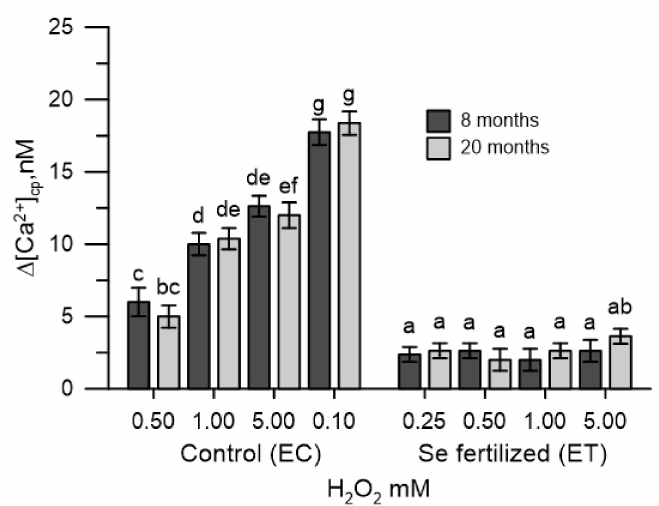
Figure 3. Effects of H 2 O 2 (0.25 to 5.0 mM) in the cytosolic Ca 2+ of olive pollen, in the presence of the extracts of the germinative apexes from untreated plants (EC 8 , EC 20 ) and Se-fertilized (ET 8 , ET 20 ). Data are expressed as means ± SEM from 4 independent tests. Different letters show significant difference at p <